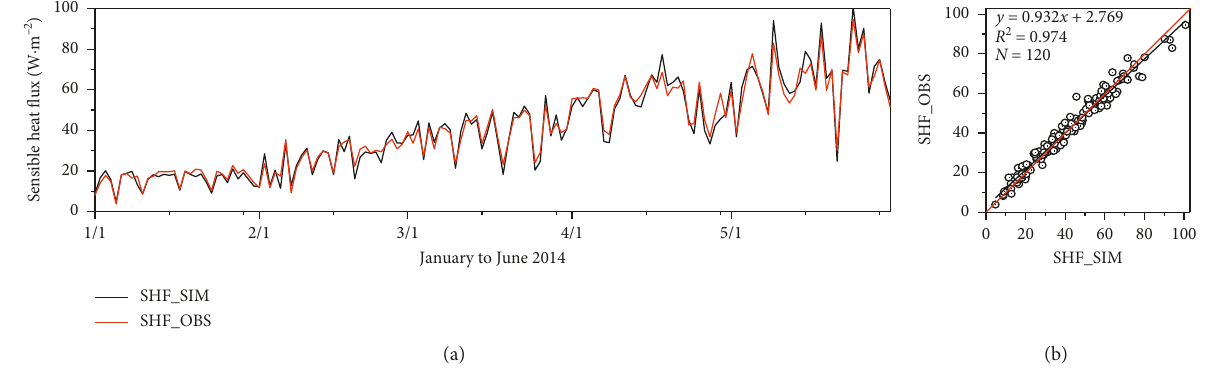
Figure 5: Contrast curve (a) and scatter plot (b) of the simulated (black) and observed (red) sensible heat flux ( H ) at the Tazhong station from January to June